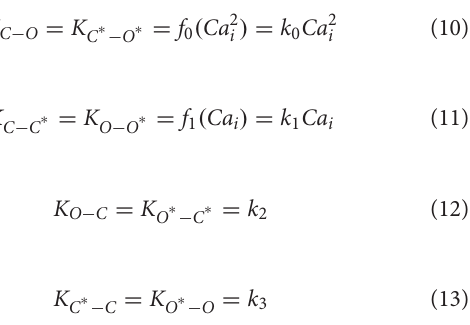
powers); transitions from the top-to-bottom, also symmetric, are linearly dependent on the local Ca i